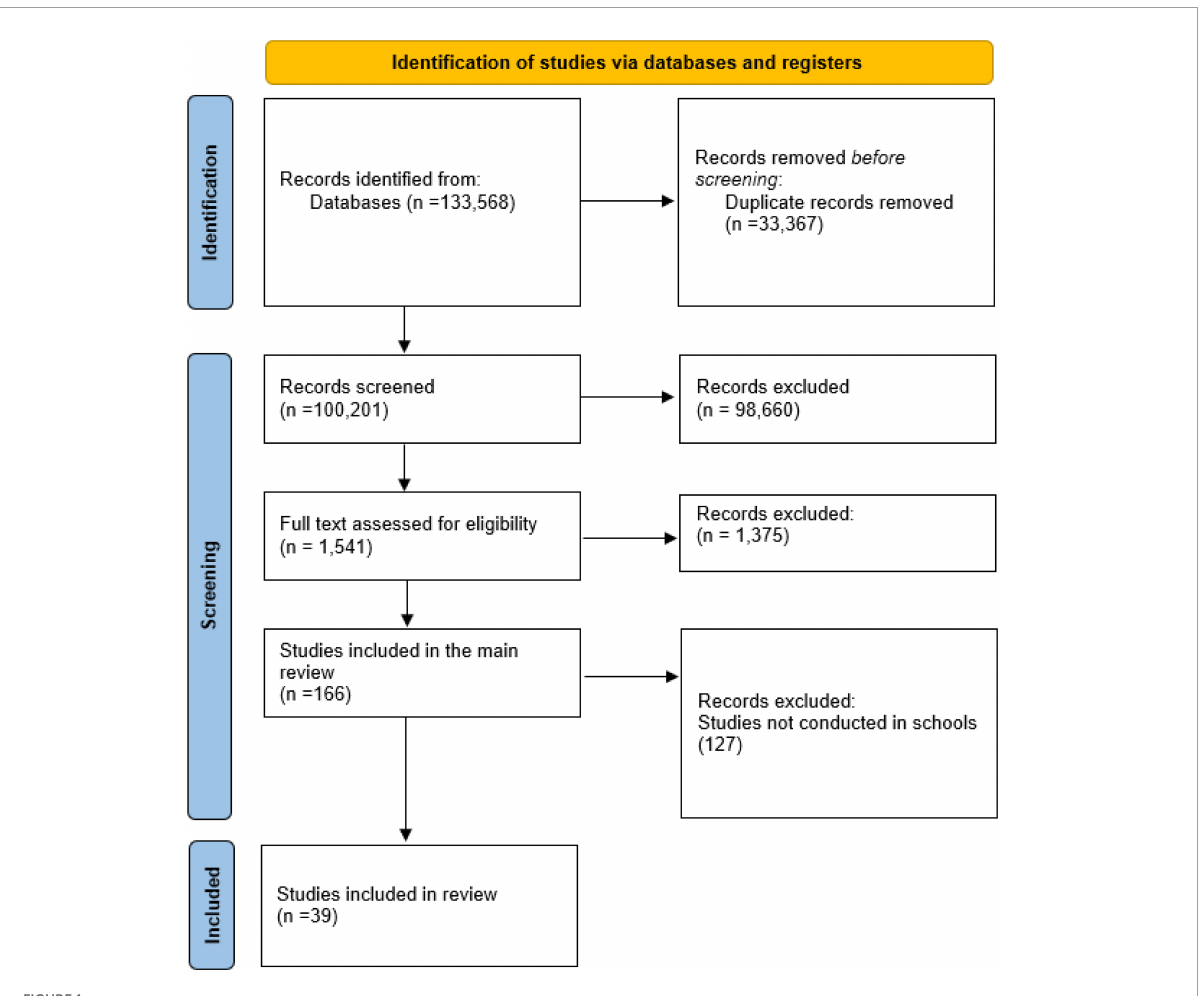
FIGURE1 PRISMA flow-chart of systematic review on school-based interventions for children and adolescent in